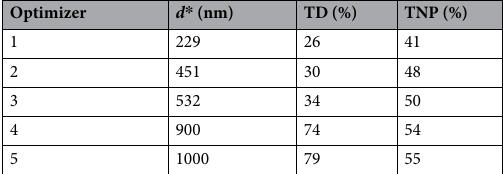
Table 2. Optimal nanoparticle sizes obtained by solving the multiobjective optimization problem in Eq. (4) showing the resulting values of TD and TNP. TD: ratio of tumor diameter after treatment to diameter at start of treatment; TNP: percent of injected nanoparticles that accumulate in tumor